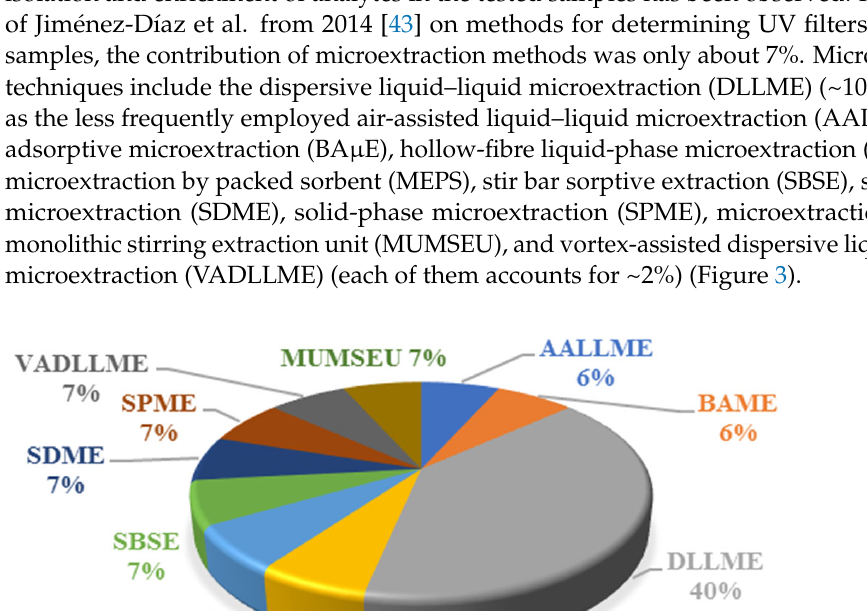
Figure 3. Microextraction techniques used for the determination of UV filters in biological samples.